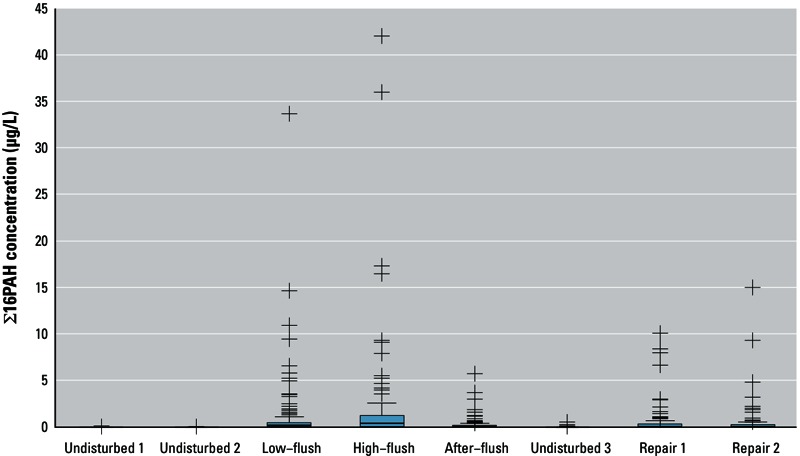
Box and whisker plot of Σ16PAH in each sample type (n = 120 for each). Boxes represent the 25th–75th percentiles; horizontal lines within boxes represent medians; whiskers extend 1.5 times the length of the interquartile range above and below the 75th and 25th percentiles; and outliers are represented as “+” symbols.